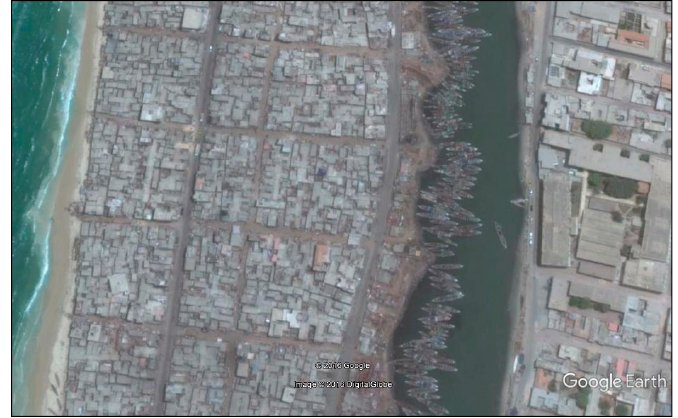
Figure 4. Aerial view of Guet Ndar along the Atlantic Ocean, showing the high building density in contrast to the Island district on the other side of the river (Google Earth ® ).